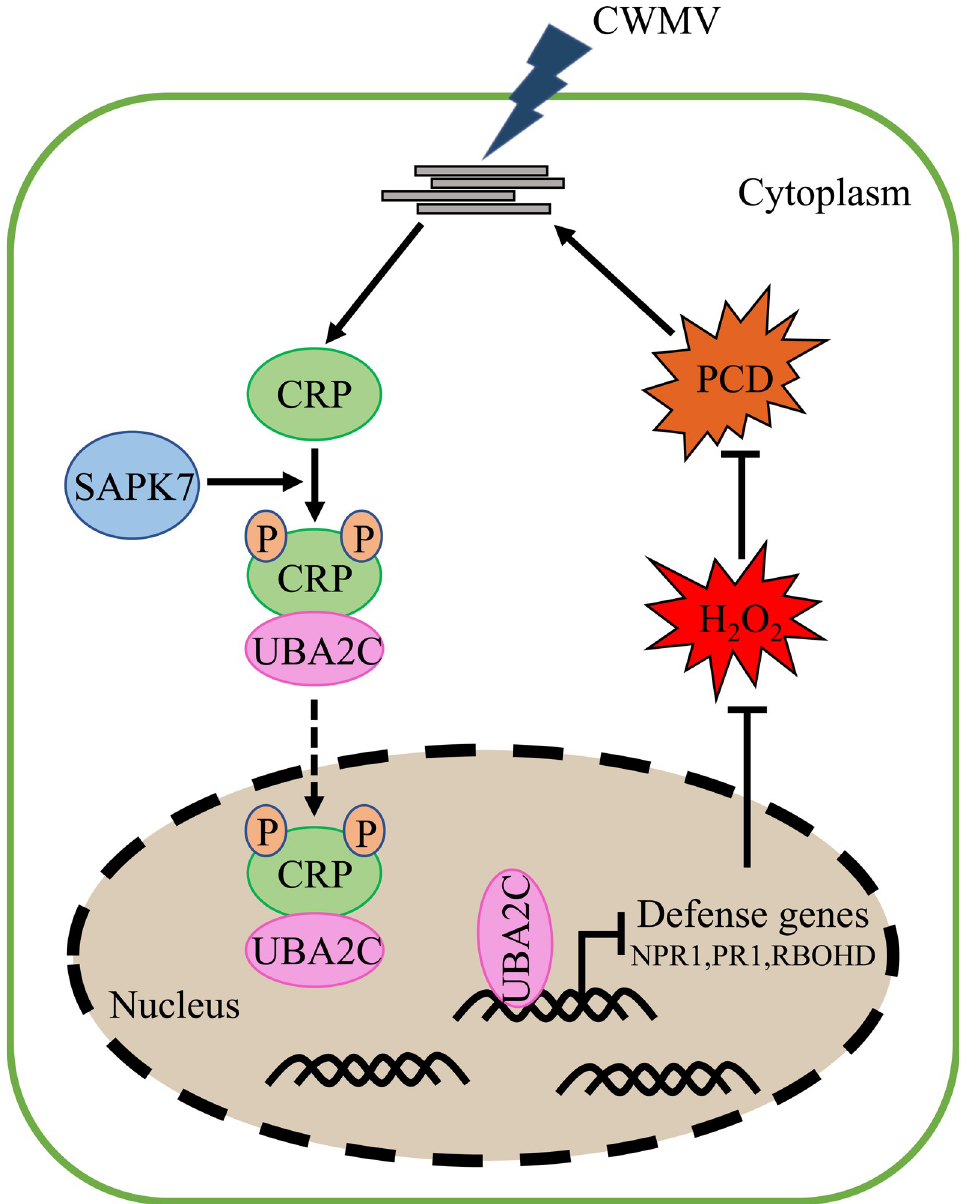
Fig 9. Working model of SAPK7 phosphorylating CWMV CRP to promote viral infection. SAPK7 phosphorylates CWMV CRP, phosphorylated CRP interactes with UBA2C, which changes TaUBA2C chromatin-bound status and attenuates its association with the TaNPR1 , TaPR1 and TaRBOHD pre-mRNA, leading the down-regulation expression of TaNPR1, TaPR1 and TaRBOHD. The decrease of these defense genes inhibit H 2 O 2 production and cell death, which in turn promotes virus